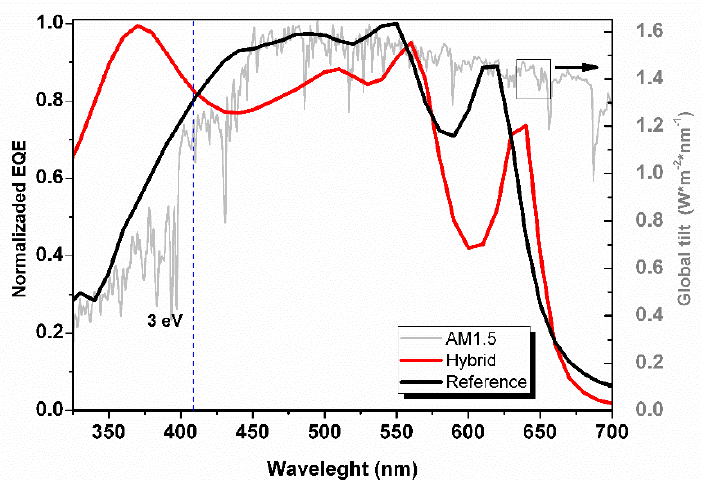
Figure 12. ( a ) External quantum efficiency (EQE) spectra of a photovoltaic structures based on amorphous silicon (a-Si:H) (REFERENCE) and a hybrid photovoltaic structure with a buffer layer and a PEDOT:PSS film treated with DIP in IPA (H6-DIP). ( b ) Comparison of EQE spectra in the range from 300 nm to 450 nm obtained using both LED and GLOBAL source.